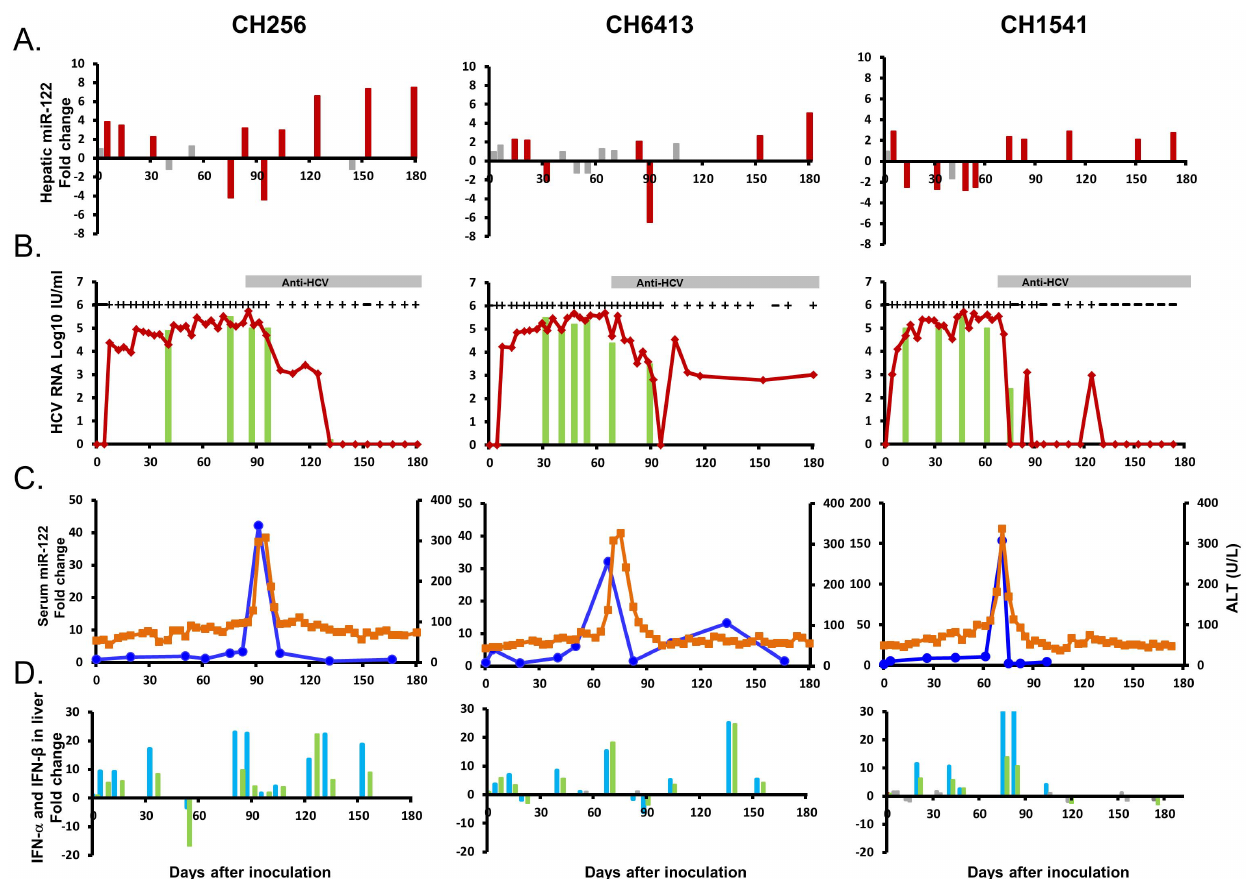
Figure 1. Acute HCV infection in chimpanzees CH256, CH6413, and CH1541. (A) Hepatic miR-122: red bars - up and down-regulated expression-fold change . 2.0; gray bars -fold change , 2.0. (B) HCV RNA titer in serum and liver: red lines represent serum HCV RNA; green bars represent HCV RNA titer in the liver. ‘‘ + ’’ denotes presence and ‘‘–’’ absence of HCV RNA in serum (detection limit 600 IU/ml). (C) Serum miR-122 levels -blue line; ALT levels- orange line. (D) IFN- a (blue bar), and IFN- b (green bar) mRNA expression.